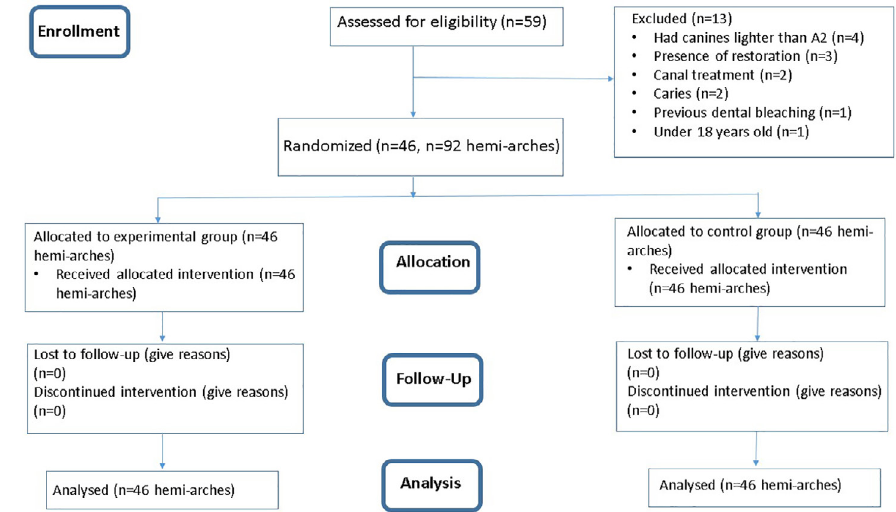
Figure 1- Flow diagram of study design phases including enrollment and allocation